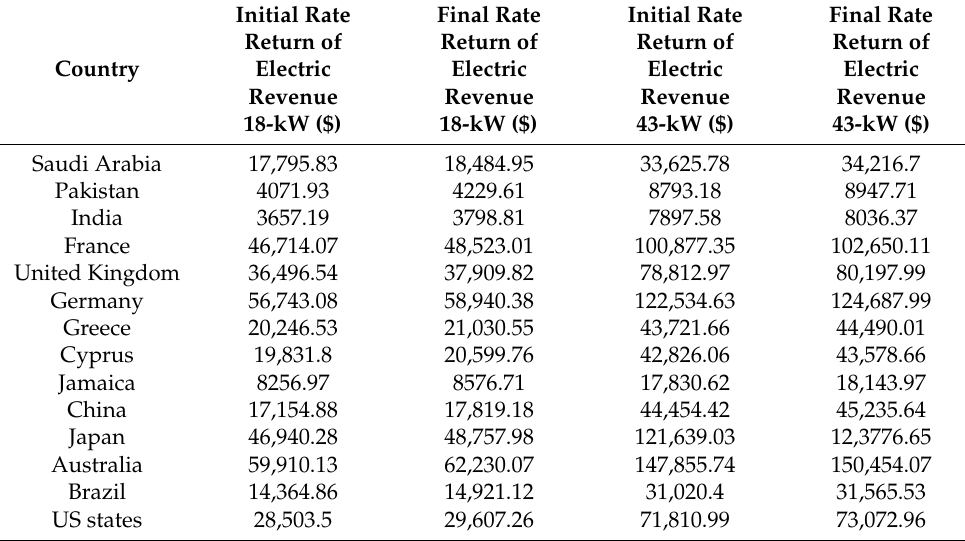
Table 6. The original and final rate returns of electric revenue associated with the two types of 10 × 10 PV arrays, without taking into account the greatest annual economic